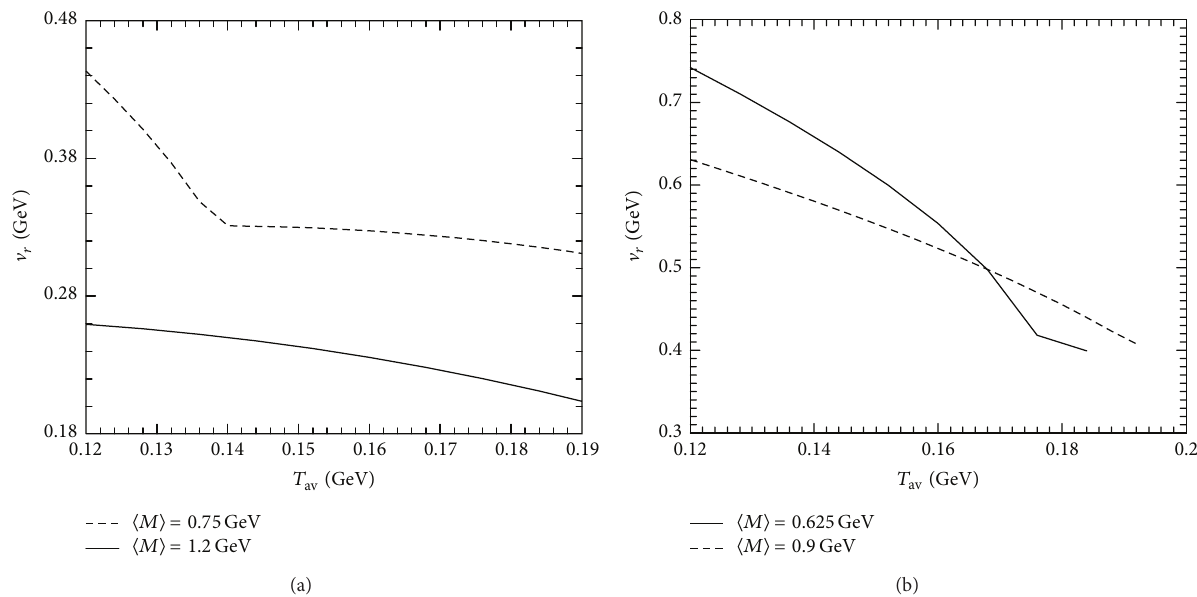
Figure 28: The variation of radial flow velocity with average temperature of the system for ⟨𝑀⟩ = 0.75 GeV and 1.2GeV at SPS energy (a) and for ⟨𝑀⟩ = 0.625 GeV and 0.9 GeV at RHIC energy